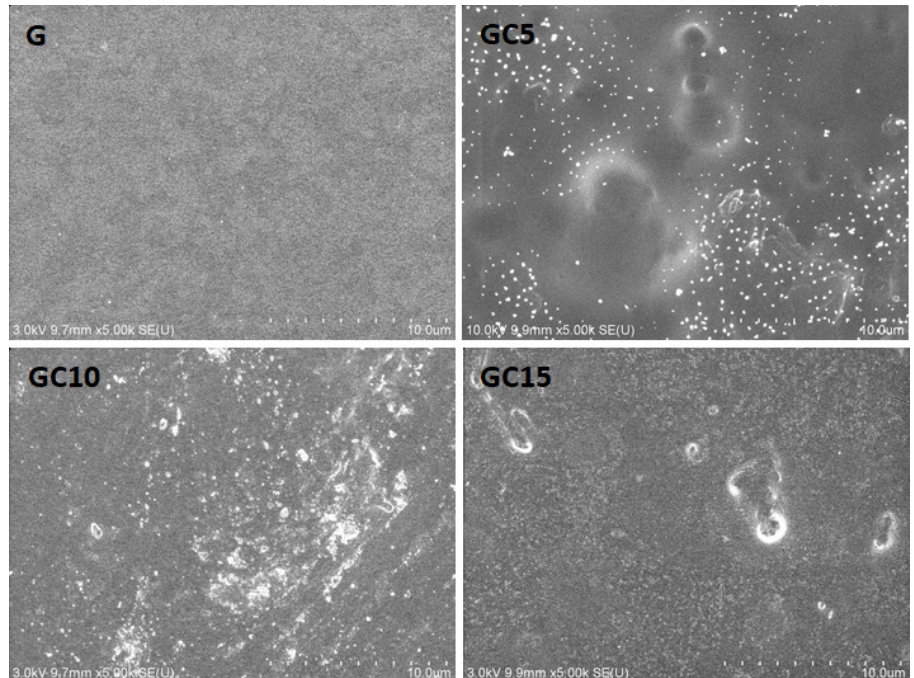
Figure 4. Morphological aspect of gelatin films reinforced with CNC.